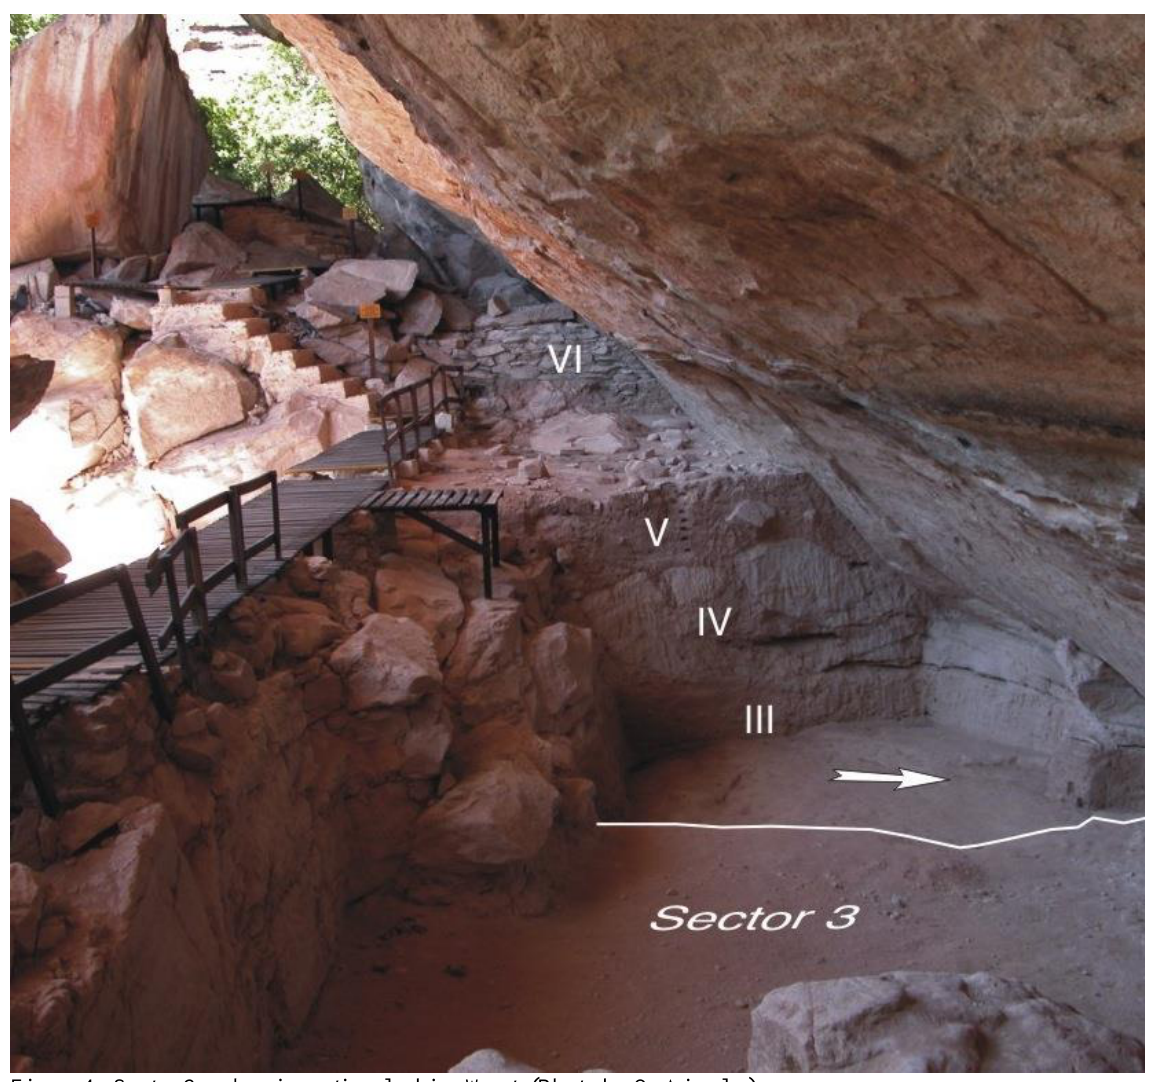
Figure 4. Sector 2 and main section, looking West. (Photo by G.